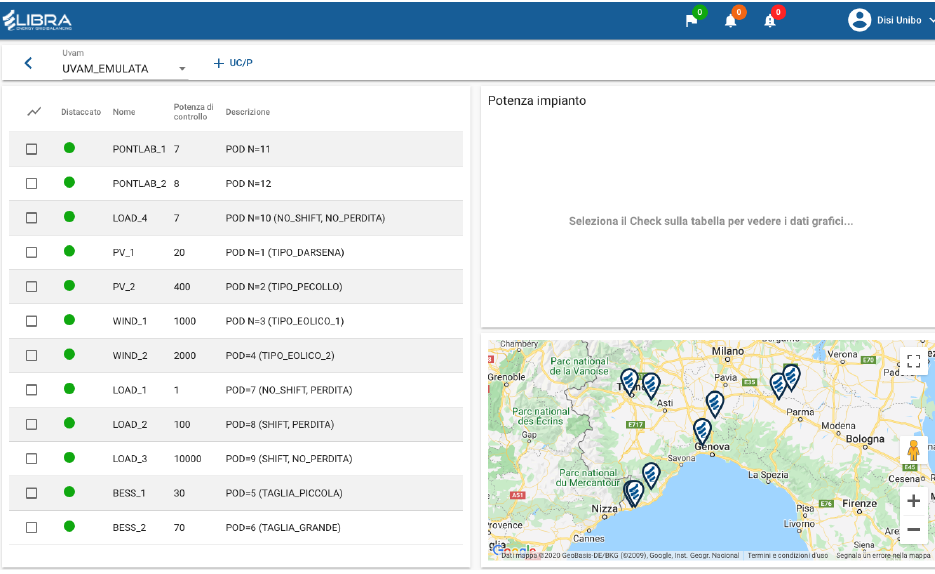
Figure 3. a graphical interface of a virtual unit composed by heterogeneous plants on LIBRA platform.